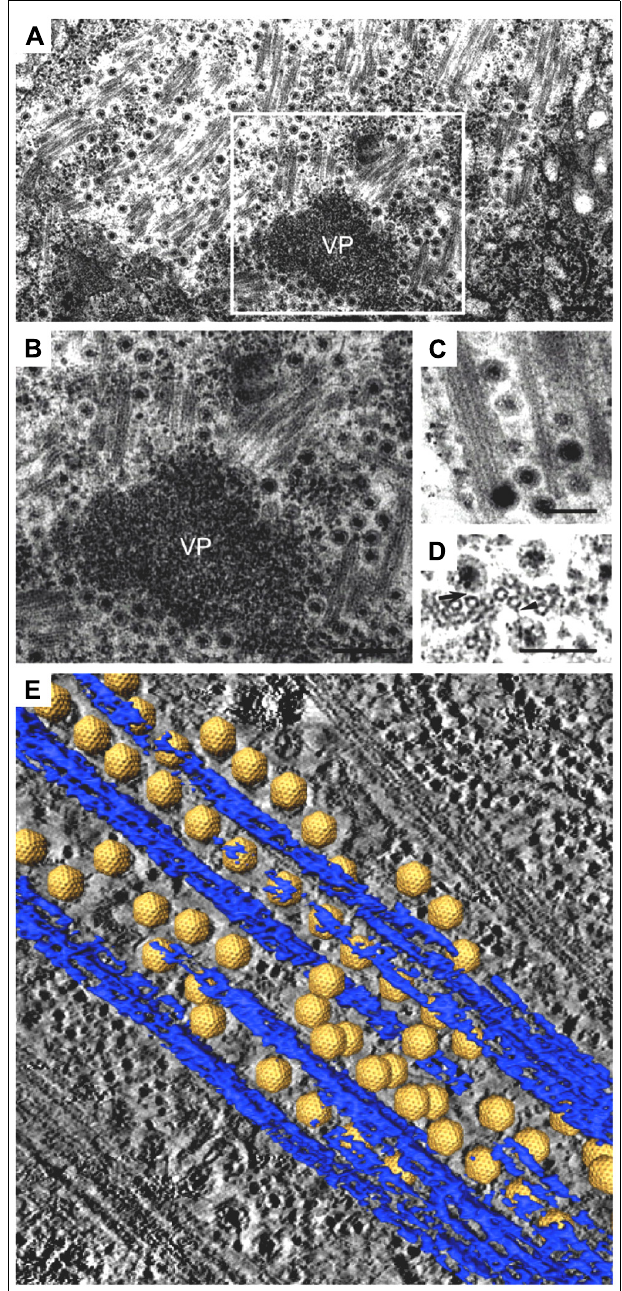
FIGURE 2 | Intracellular trafficking of Rice gall dwarf virus (RGDV) particles. (A) RGDV particles associated with microtubules in virus-infected VCMs 48 h p.i. Scale bar, 300 nm.Viroplasm (VP), an electron-dense inclusion, is also seen in the electron micrograph. (B) Enlarged view of the boxed region in (A) . Scale bar, 300 nm. (C) Viral particles along the edges of tubules, approximately 25 nm in diameter. Scale bar, 150 nm. (D) Transverse sections of arrays of closed circles of approximately 25 nm in diameter with viral particles directly attached to their circumference (arrow) or via a filament (arrowhead). Scale bar, 150 nm. (E) Three-dimensional surface-rendered model showing the association of RGDV particles (yellow) with microtubules (blue). Reproduced with permission fromWei etal.